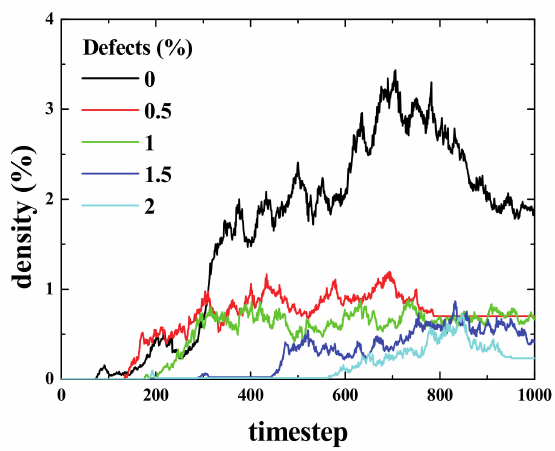
Figure 15. (Color online) Mixed density vs. time for five different percentages of defects as labelled. As can be seen, the lower the number of defects, the easier it is for the two blocks to interact. The connectivity was achieved in several timesteps that depended on the densities of the upper and lower regions (See Figure 16, right panel). For low densities, the time was larger, and then for densities ≥ than 20%, it was approximately 125 steps, the gap distance was 100 cells, meaning that the communities “moved” towards each other with a velocity v = 50/125 = 0.4 grid-cells/timestep. Then for a given density (20% in this case), the time needed to interact will depend on the percentage of defects present in the middle region (Figure 16 left). When the percentage of defects is less than or equal to 0.75%, the effect is almost negligible; however, for bigger percentages, the time clearly increases, and when the defects reach more than 2% of the grid in the middle region, the signal is almost blocked.